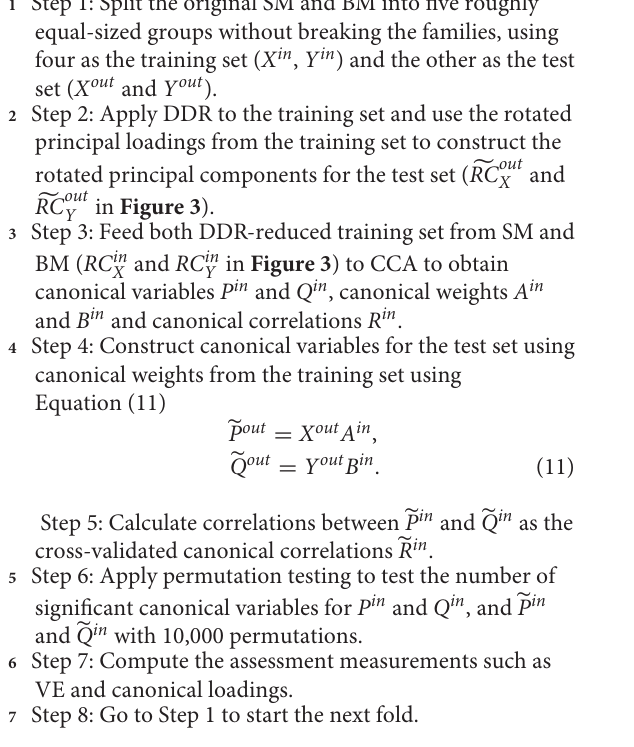
TABLE 1 | Summary table for Principal Component Analysis (PCA) Canonical Correlation Analysis (CCA) with 5 different input dimensions of CCA (first column). CCA input